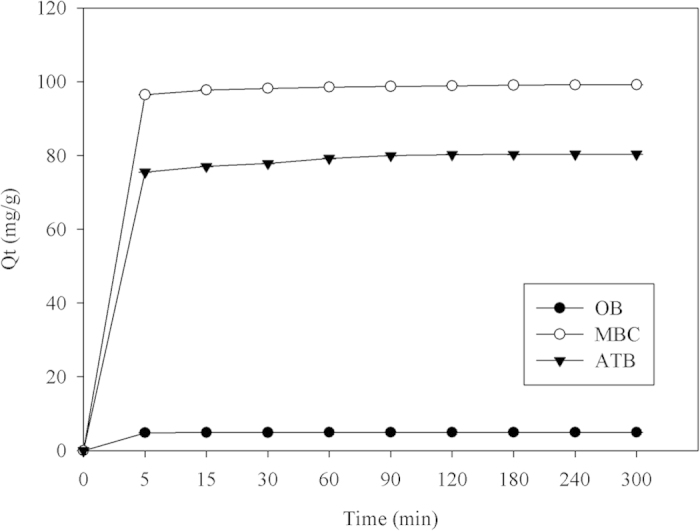
Comparison of adsorption capacities of original biochar (OB), acid-treated biochar (ATB), and Fe3O4 coated biochar (MBC).